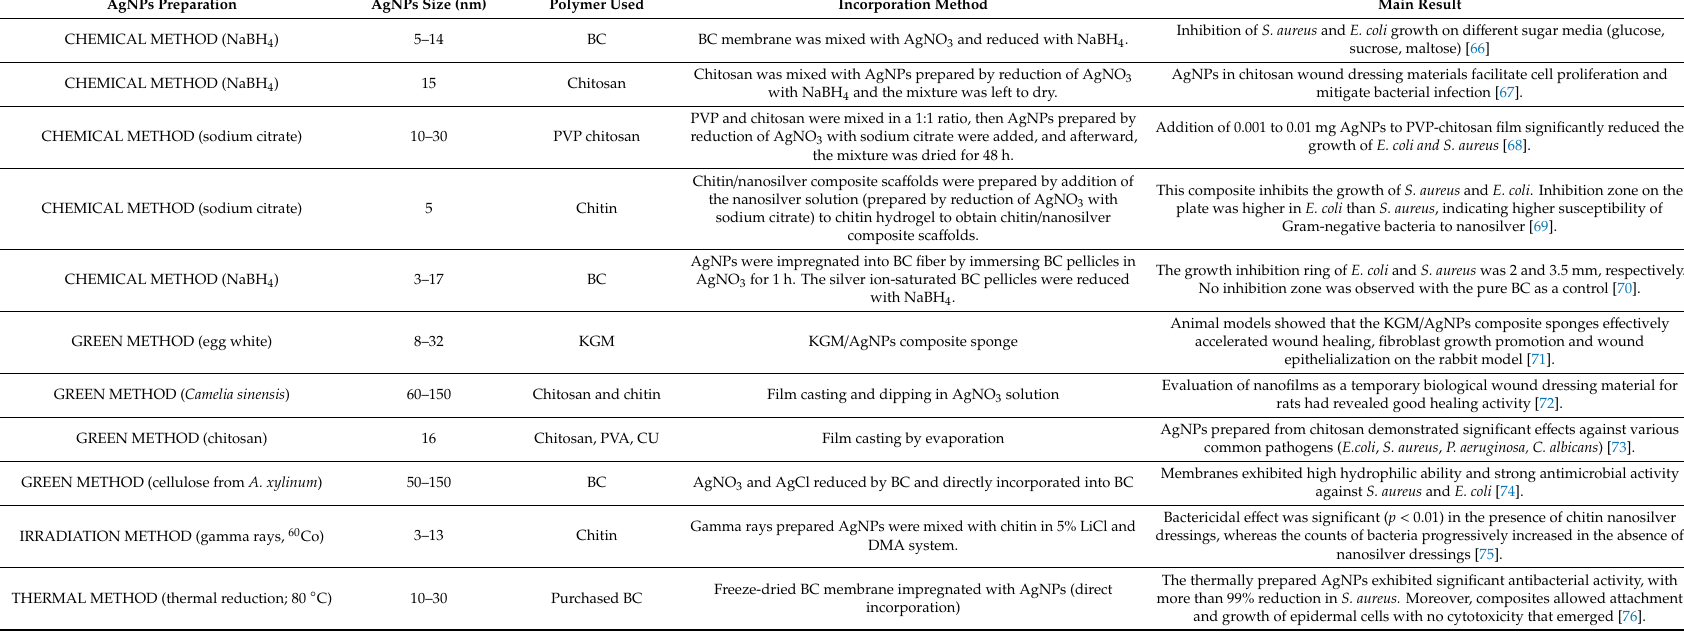
Table 1. AgNPs-membrane composites for wound